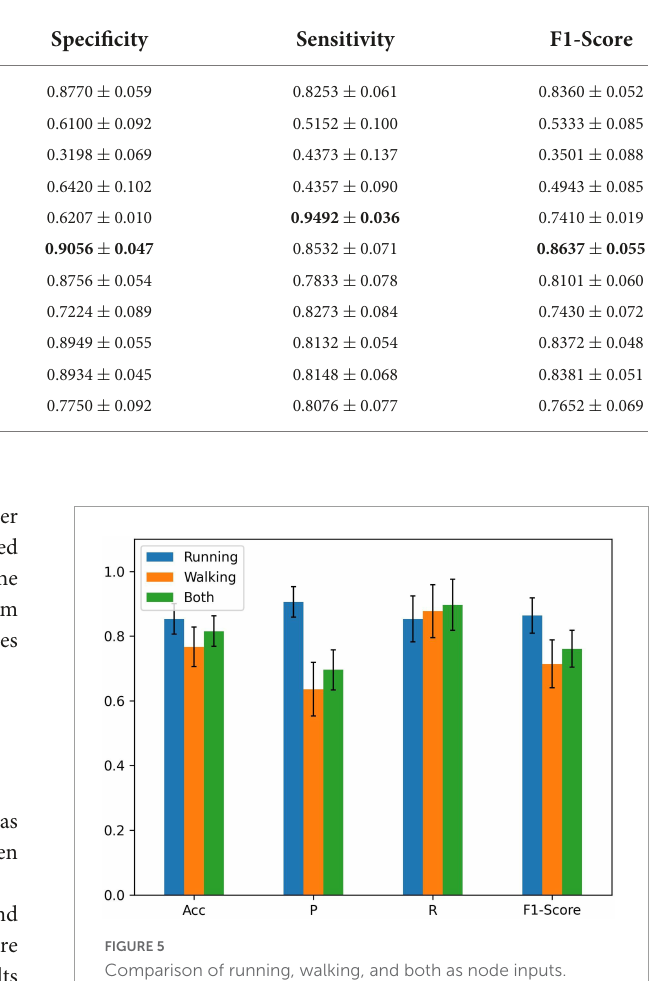
control group, the correlation is stronger for the knee and ankle joints among the three variables of joint kinematics. The correlations are strong for the same muscle groups, except for the rectus femoris of the quadriceps. However, correlations between the quadriceps and other muscle groups were significantly lower in the pain group than in the control